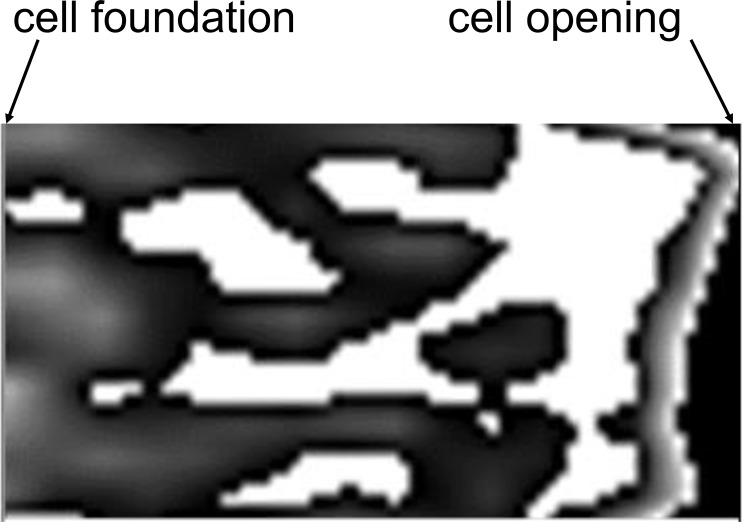
Sagittal view of a cell with content density increasing towards the cell opening (on the right side).